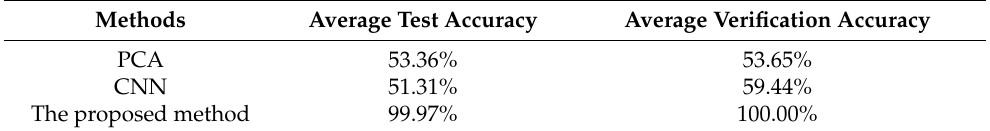
Table 8. The results of five rounds of crossover experiments with different feature extraction